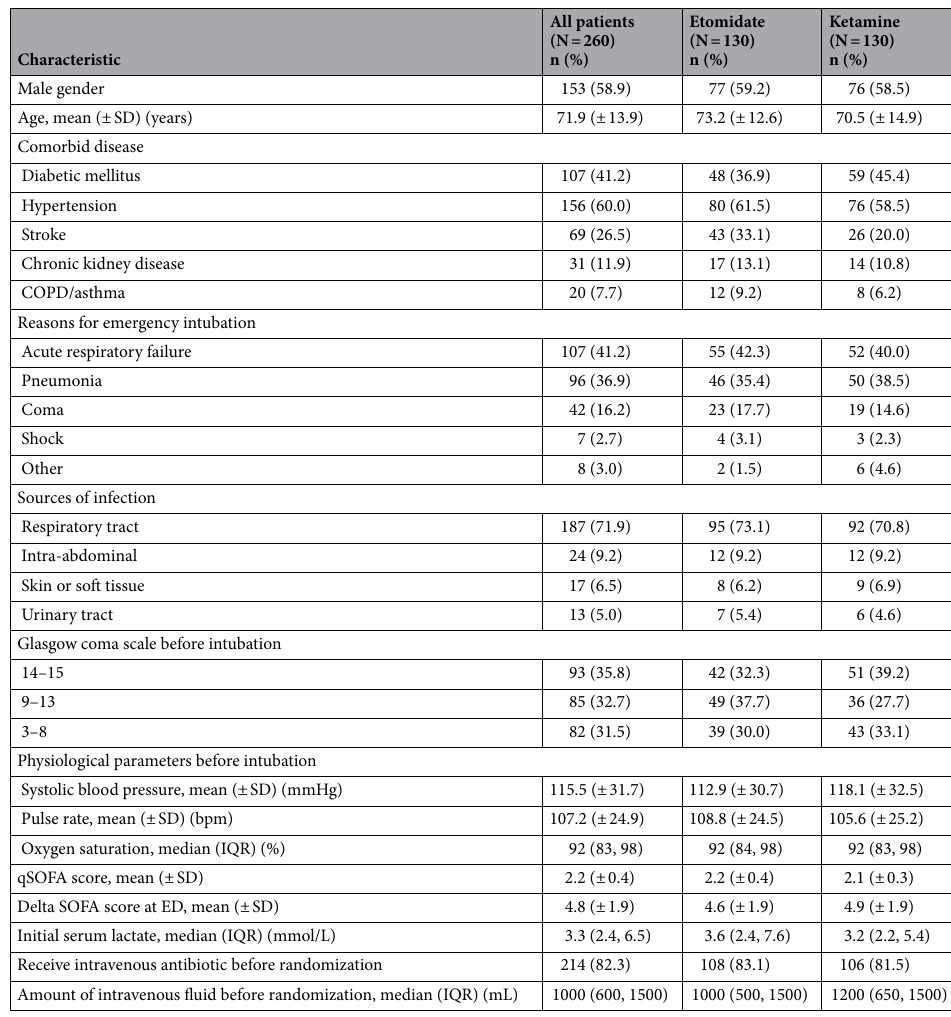
(Table 3 and Fig. 2). Regarding peri-intubation adverse events, cardiac arrest during intubation occurred in two patients (1.5%) in the etomidate group and two patients (1.5%) in the ketamine group (RD, 0%; 95% CI, − 2.9 to 2.9%; P = 1.0). Two patients (1.5%) in the etomidate group, but none in the ketamine group, were diagnosed with failed intubation. There was no significant difference between the study groups in the proportion of patients with postintubation hypotension (11.5% vs. 10.8%; RD, 0.7%; 95% CI, − 6.9 to 8.4%; P = 0.843); however, there were significant dif- ferences between the etomidate group and the ketamine group in the proportion of patients who needed a vaso- pressor within 24 h after intubation (43.9% vs. 17.7%, respectively; RD, 26.2%; 95% CI, 15.4 to 36.9%; P < 0.001) and the proportion of patients who received intravenous corticosteroids (14.6% vs. 5.4%, respectively; RD, 9.2%; 95% CI, 2.1 to 16.4%; P = 0.012) (Table 3 and Fig.